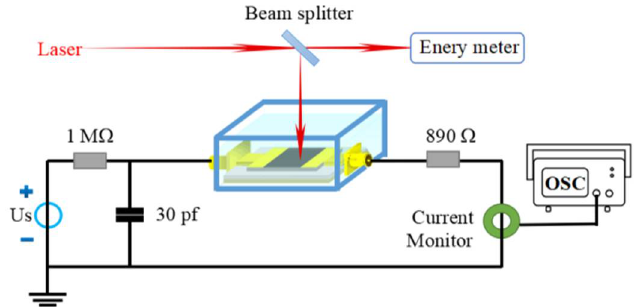
Figure 4. GaAs PCSS testing circuit.